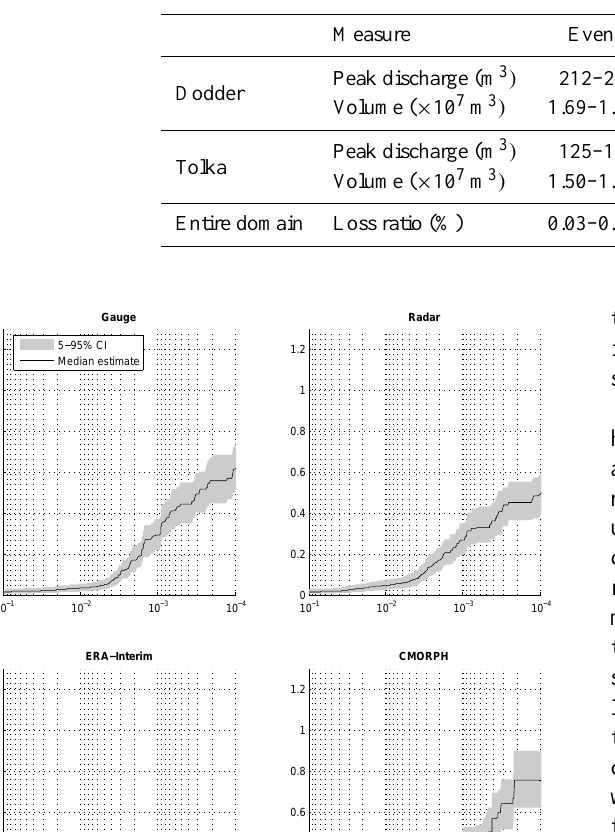
Table 2. Weighted 5th–95th-quantile values for event-based HBV uncertainty simulations.